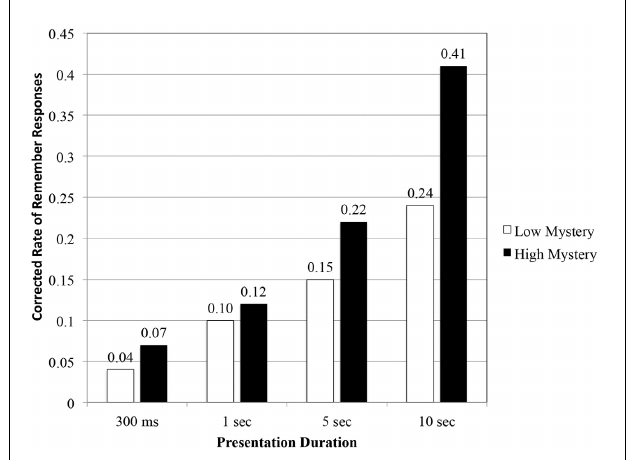
FIGURE 5 | Corrected rate of remember responses as a function of scene type and presentation